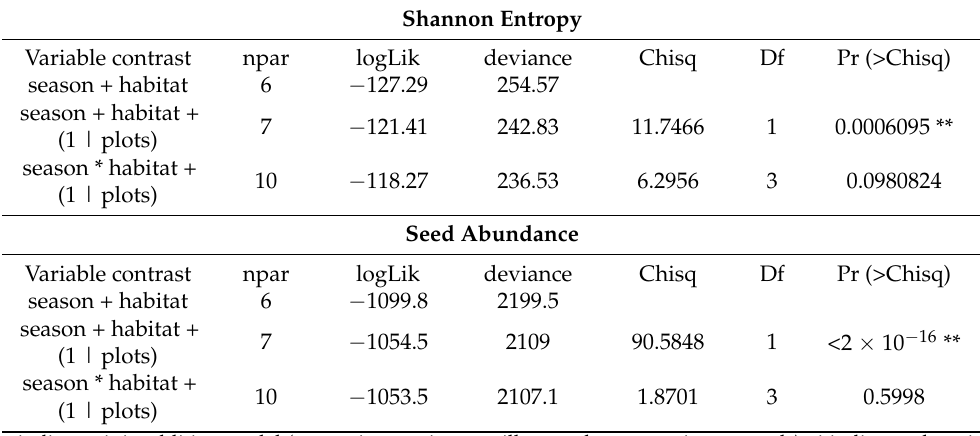
Table 1. Generalized Linear Model comparison for Shannon entropy and seed abundance in the topsoil seed